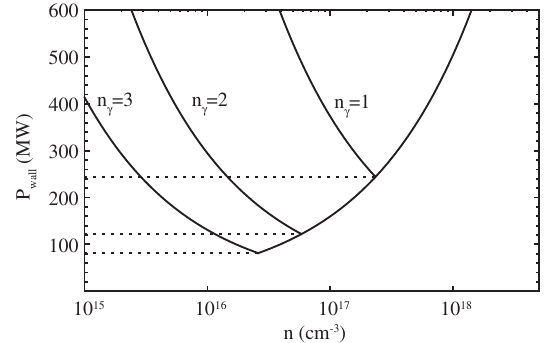
FIG. 1. Total AC power required versus plasma density for a 1 TeV center-of-mass collider with (cid:3) 2 (cid:3) ¼ 100 nm 2 , L ¼ 2 (cid:7) 10 34 s (cid:1) 2 cm (cid:1) 2 , and (cid:9) ¼ 6% , with the number of beamstrahlung photons produced per electron bounded with n (cid:4) ¼ 1 , n (cid:4) ¼ 2 , and n (cid:4) ¼ 3 . The solid line is single-bunch operation and the dashed line is using multibunch trains (with fixed n b =n